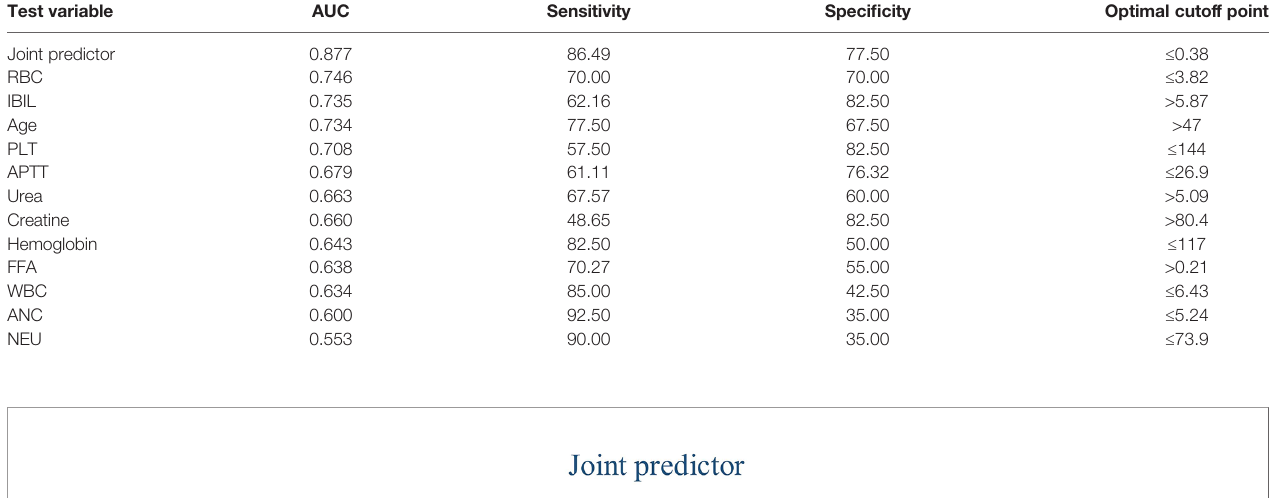
TABLE 7 | Predictive value of each test variable.